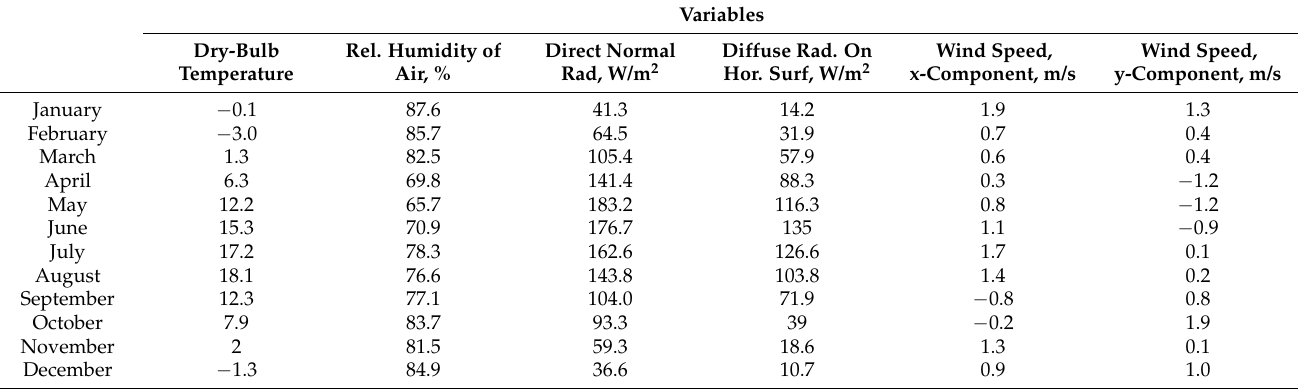
Table 1. Outdoor average climate data for Riga (source: ASHRAE).